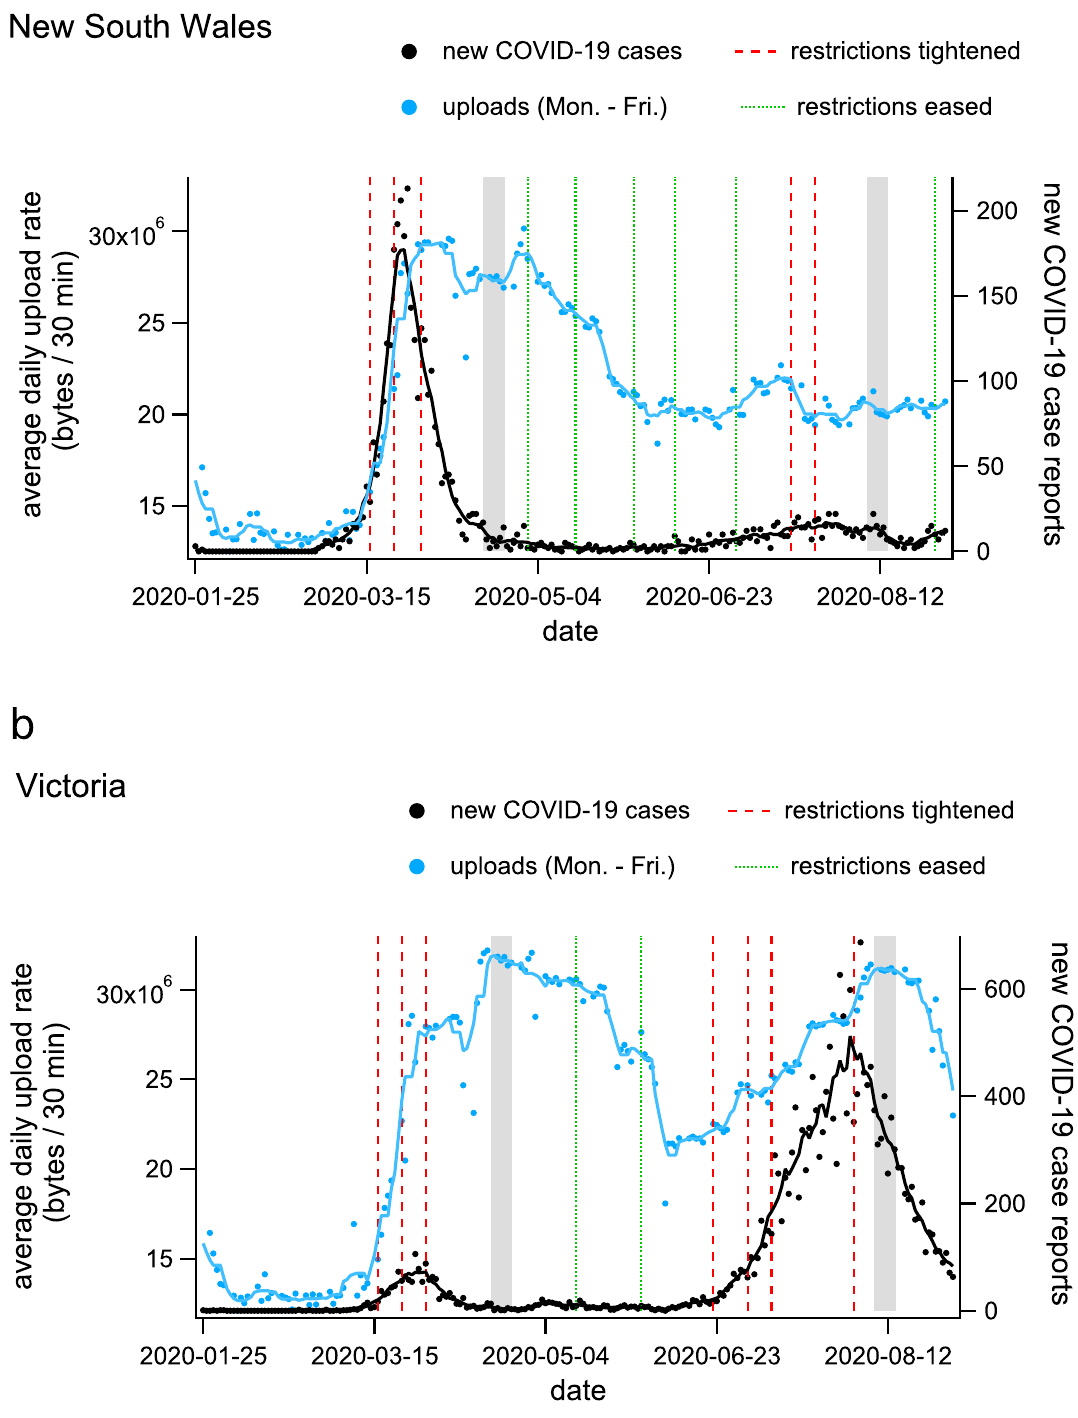
Figure 4. Timeseries plots of average daytime internet use, COVID-19 case incidence, and restriction policy implementation for ( a ) New South Wales and ( b ) Victoria, Australia. Daily average upload rates per household, per 30 min interval between 9 a.m. and 12 p.m. are shown as blue dots for weekdays (blue dots, the blue line is the 7-day average). Daily case incidence is shown as black dots (the black line is the 7 day average), and dates on which restriction policies were modified are shown as vertical dashed lines for increasing (red) and decreasing (green) restriction levels. The grey bands indicate the dates over which nbn data was averaged for our analysis of first- and second-wave changes. See the Supplementary Fig. S1 for an equivalent timeseries presenting average downloads rather than